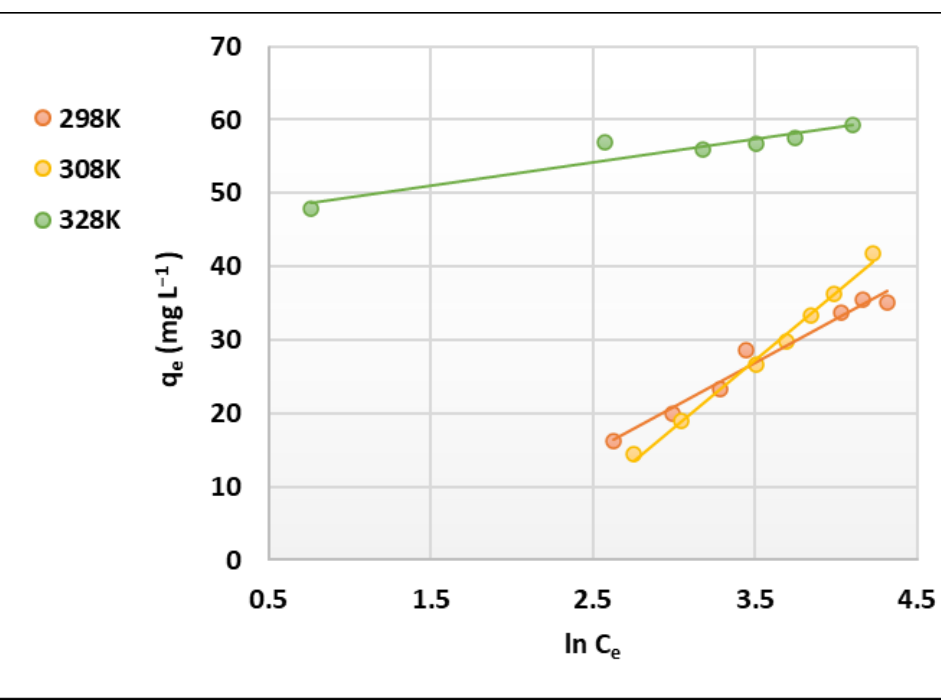
Figure 21. The plots of Temkin isotherm for CR dye adsorption onto 2Clph-BU-Cs adsorbent (m = 0.01 g, C 0 = 30–120 mg L −1 , V = 100 mL, pH = 4, and time = 48 h).